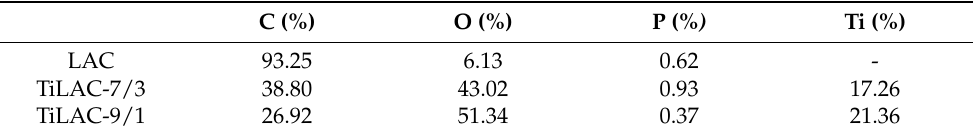
Table 3. Atomic surface composition in (%) from XPS